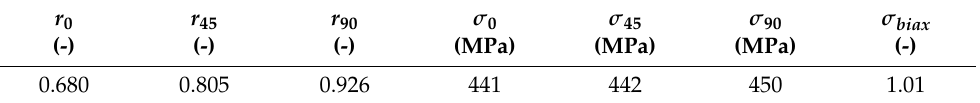
Figure 5. Comparison of Hill48 and Hill90 yield criteria used in FE analysis. Table 3. The anisotropy parameters describing the yield criteria.